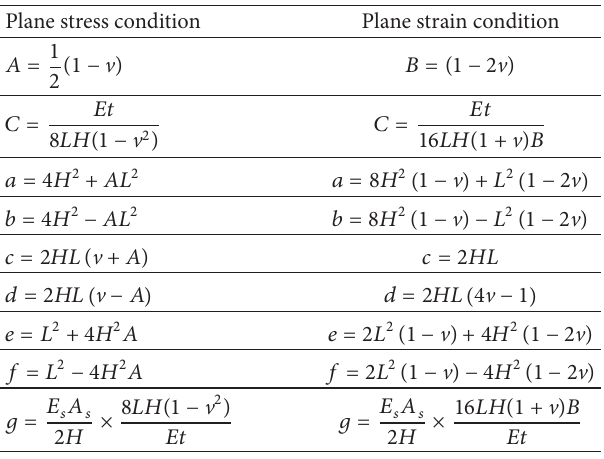
Table 2: Stiffness matrix variables. Plane stress condition Plane strain condition